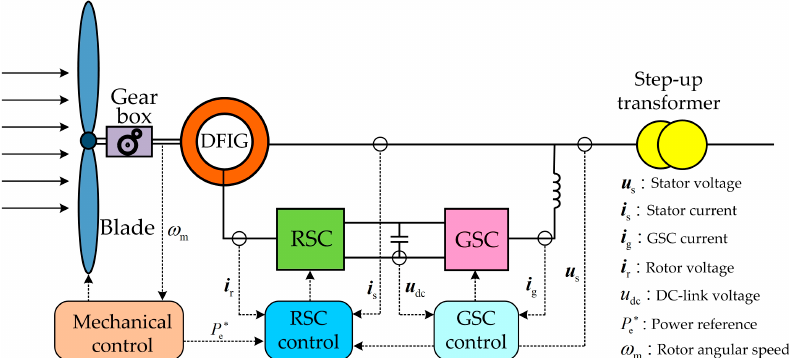
Figure 2. Doubly ‐ fed induction generation (DFIG) system. Figure 2. Doubly-fed induction generation (DFIG)